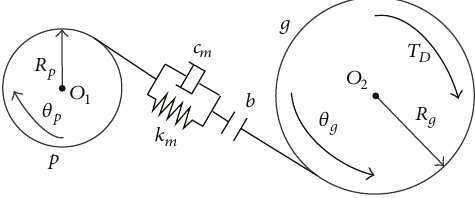
Figure 18: A simplified model of a rattling gear pair.